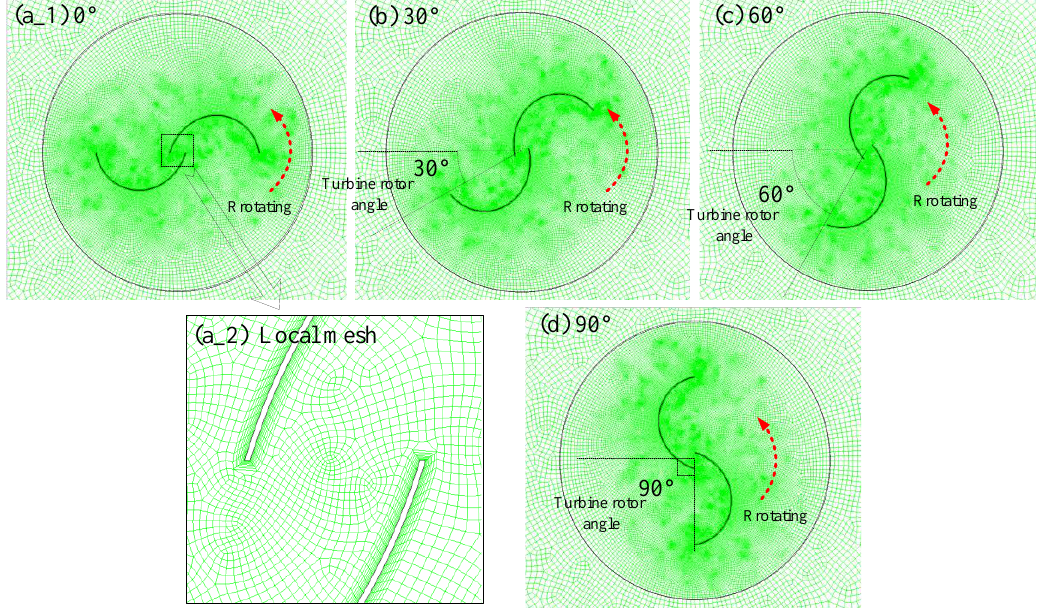
Figure 5. Relative rotation positions around the blades at different rotor angle.